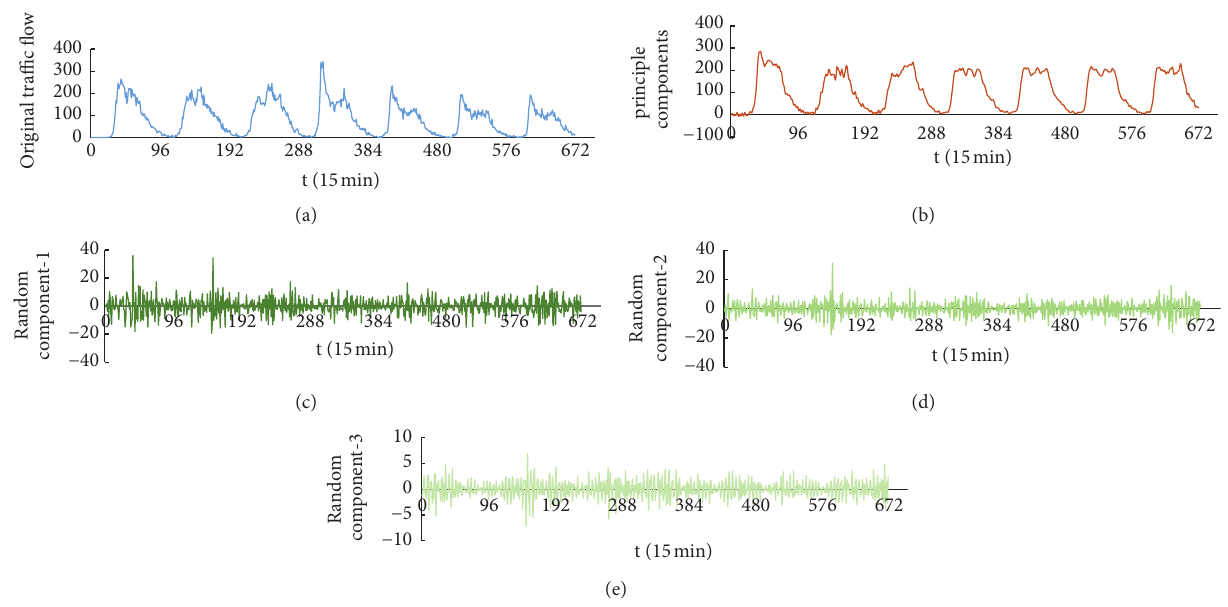
Figure 5: Traffic flow decomposed by SSA. (a) Original traffic flow of a week, (b) the first component—principle component, (c) the second component—random component 1, (d) the third component—random component 2, and (e) the fourth component—random component